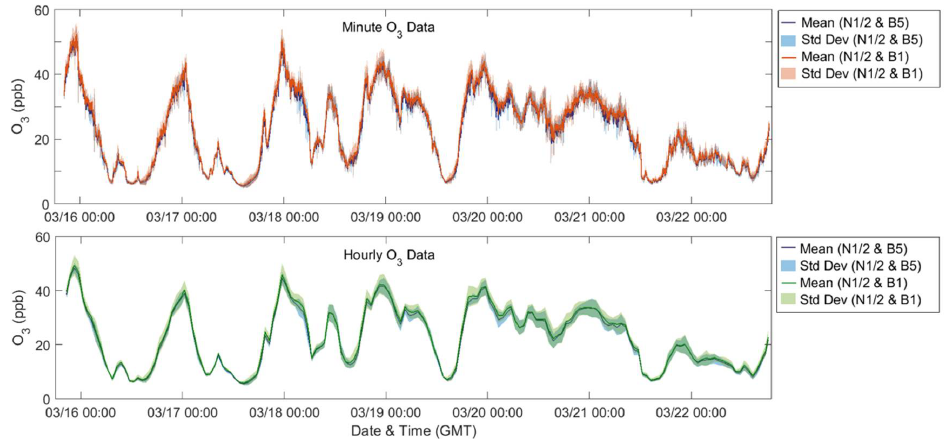
Figure 11. Time series of O 3 data ( top : minute-median, bottom : hourly-averaged), showing the mean and standard deviation of different sets of Y-Pods.